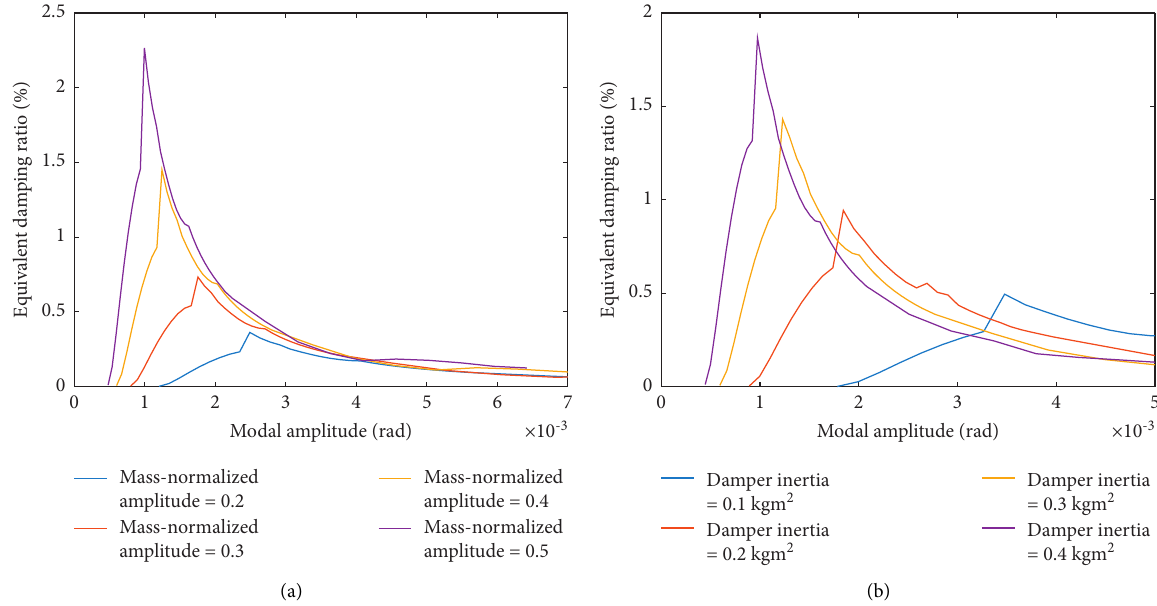
Figure 11: Influence of the mass-normalized modal amplitude at the damper (a) and the rotational inertia of the damper (b) on the equivalent damping